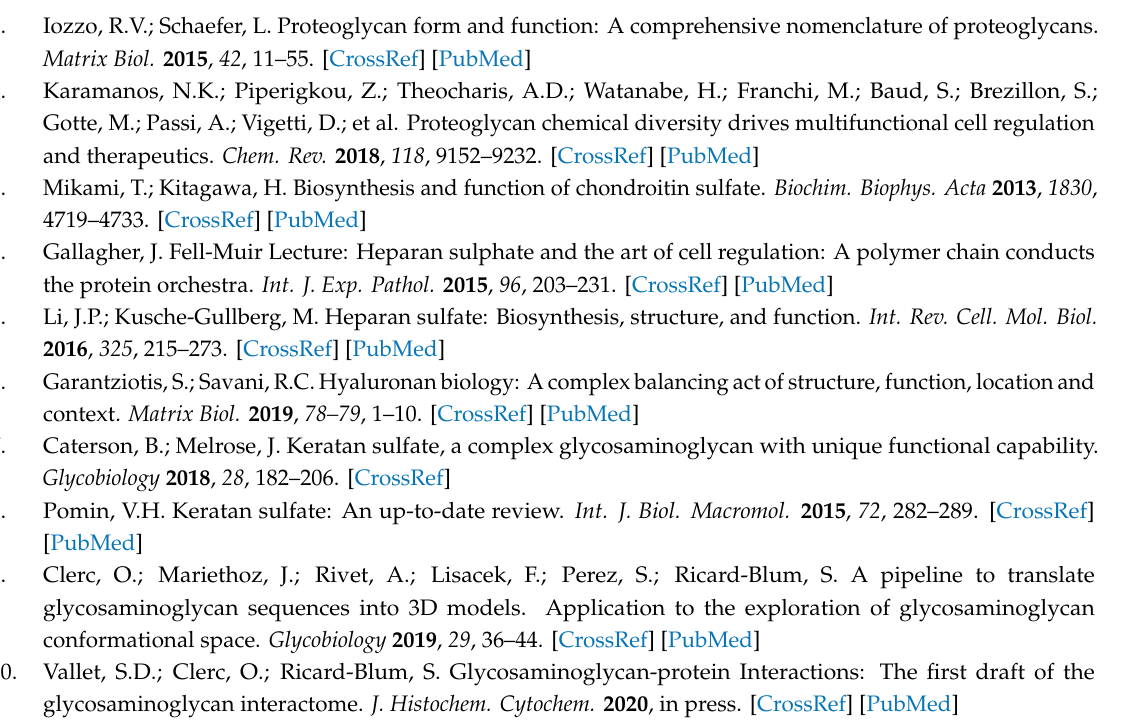
Figure S1: Detailed of the analysis of GAG binding in crystal structure of a ternary FGF1-FGFR2-Heparin complex (PDB 2GD4) available from di ff erent souces; PDBe; Swiss-Model; PLIP, LIGPOLT. Figure S2: Quaternary organisation in the crystal Structure of the Antithrombin-S195A Factor Xa-Pentasaccharide Complex (PDB 1EO0) computed and displayed by